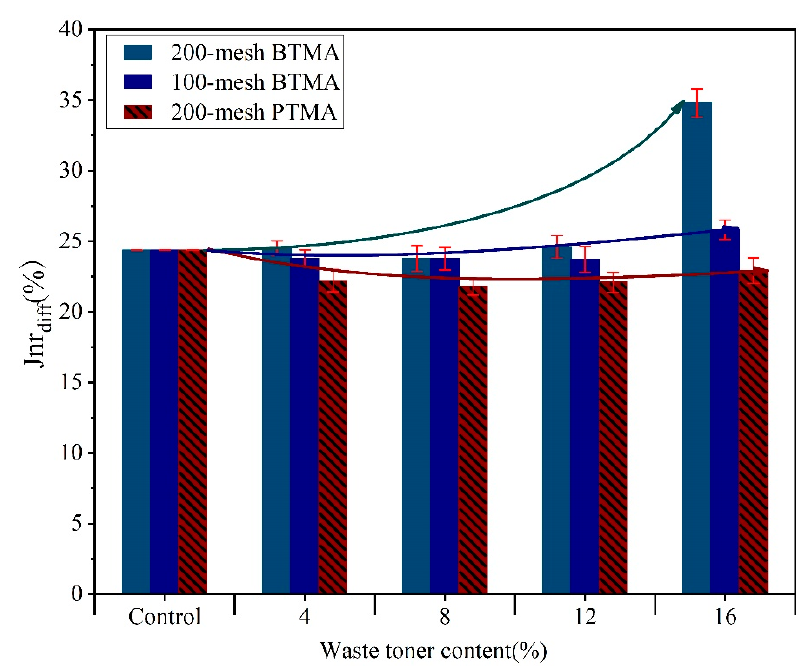
Figure 9. J nr -diff for all Figure 9. Jnr ‐ diff for all binders.